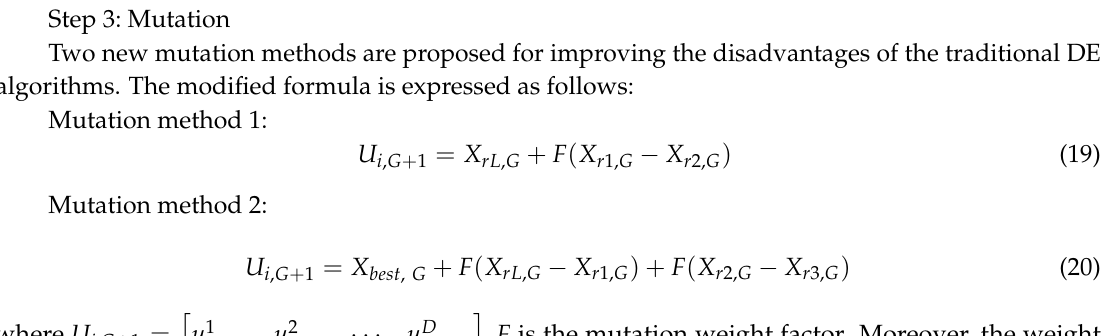
Figure 8. Generation of the second group leader.